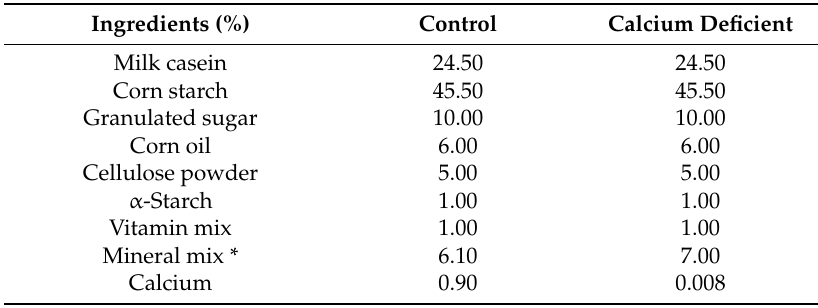
Table 1. Composition of the experimental